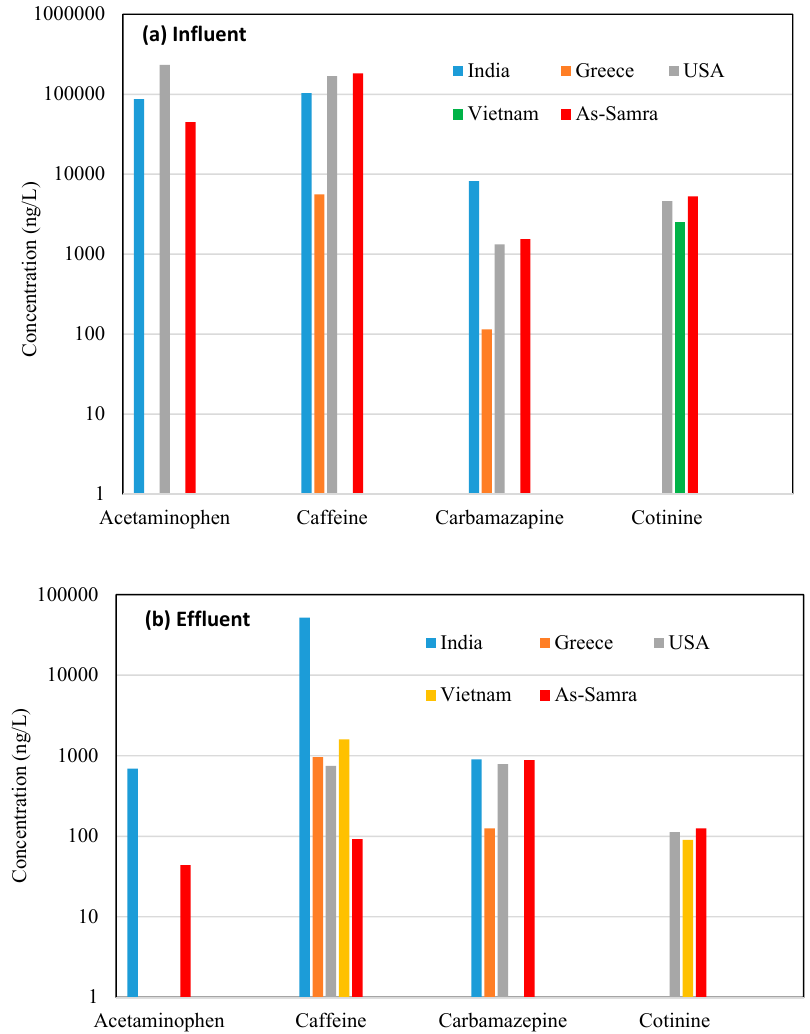
Figure 3. Concentrations of acetaminophen, ca ff eine, carbamazepine, and continine (ng / L) in Figure 2. Concentrations of acetaminophen, caffeine, carbamazepine, and continine (ng/L) in Influent Influent ( a ) and E ffl uent ( b ) of wastewater treatment plants (India, Balakrishna et al. [40]; ( a ) and Effluent ( b ) of wastewater treatment plants (India, Balakrishna et al. [40]; Greece,